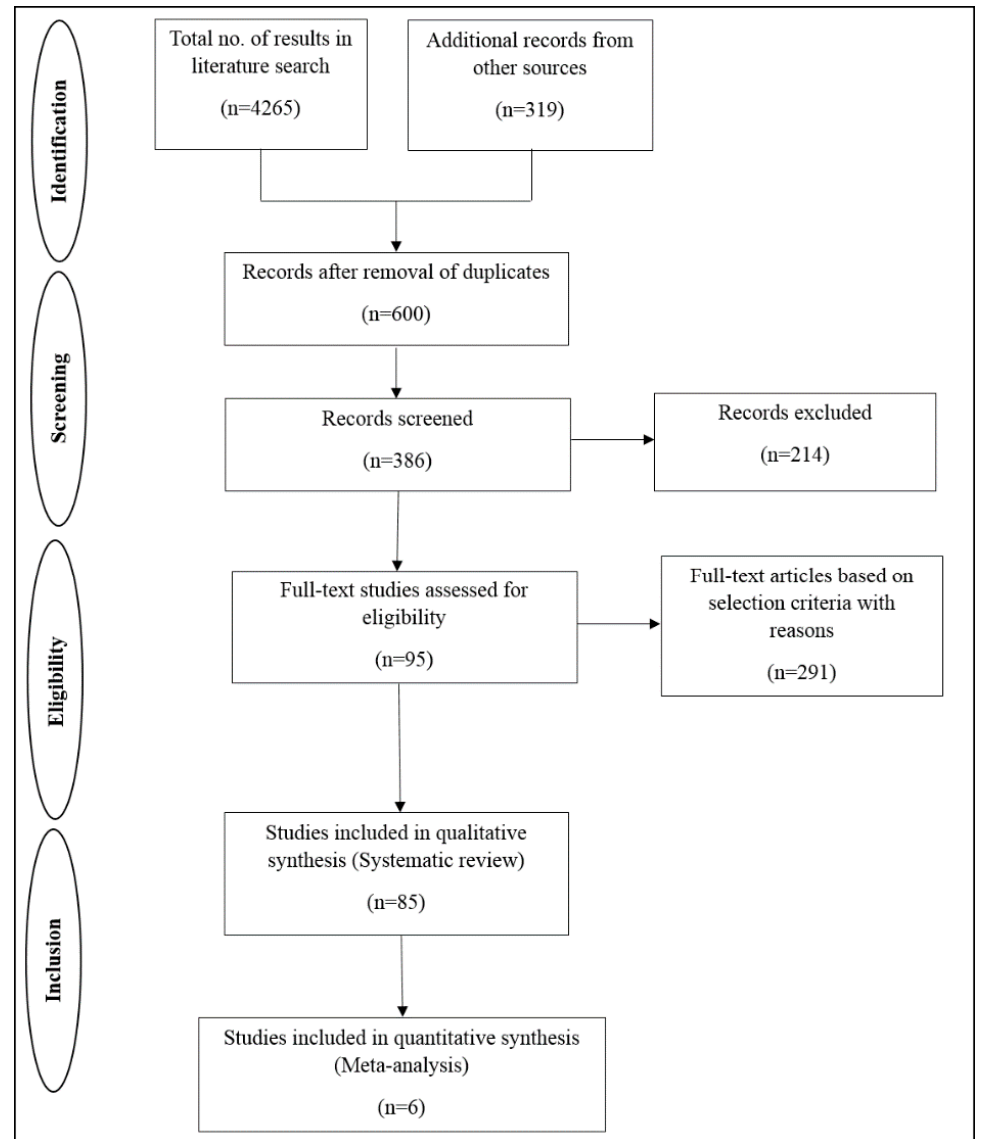
Figure 1. Flowchart of our literature search.